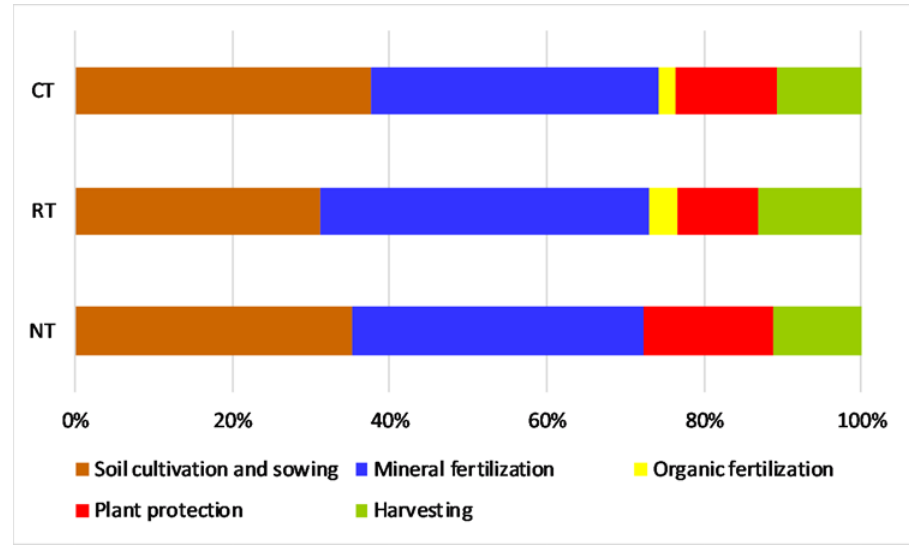
Figure 9. Contribution of field operations to the life-cycle costs of the maize production in conventional tillage (CT), reduced tillage (RT) and no-tillage (NT).